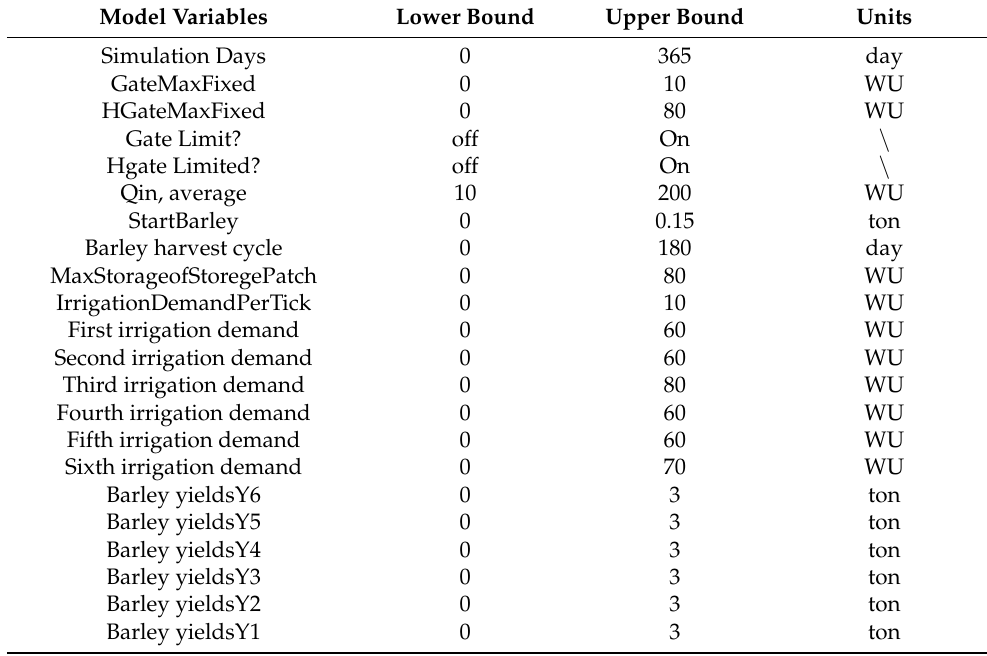
Table A1. The parameters used in this